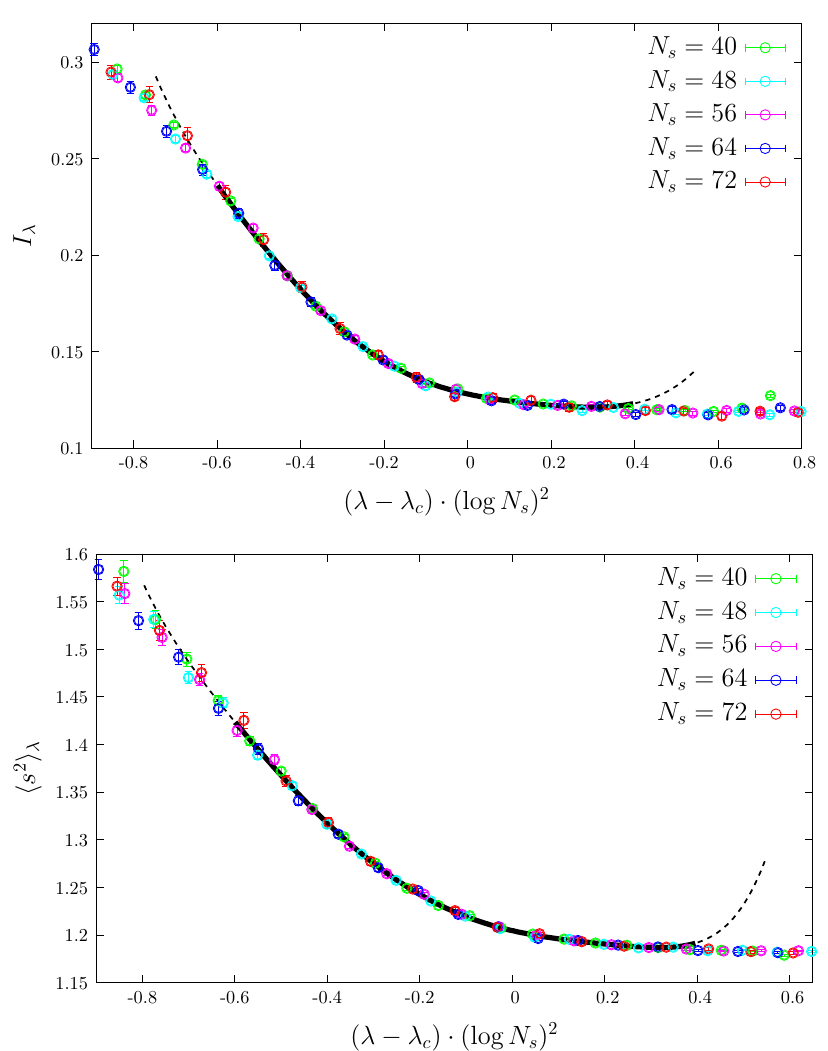
Figure 8 . Scaling behaviour of I λ (top) and (solid line) was obtained via constrained fitting using w = 0 . 06, N s min = 40 and σ = 8. The scaling behaviour is seen to persist also outside the range where the fit was performed, where the fitted function does not match the data points (dashed